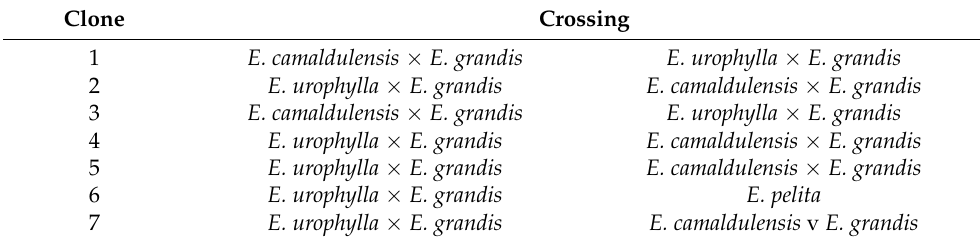
Table 1. List of clones of the hybrids of Eucalyptus urophylla used in this work. Clone Crossing